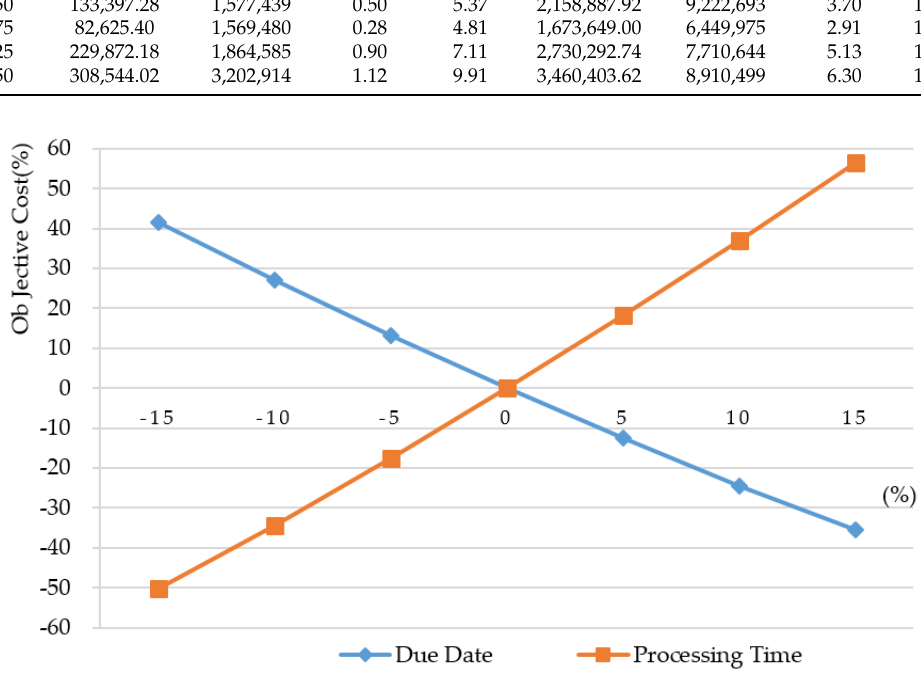
p and d on objective cost. Figure 3. The influence of p j and d j on objective j j